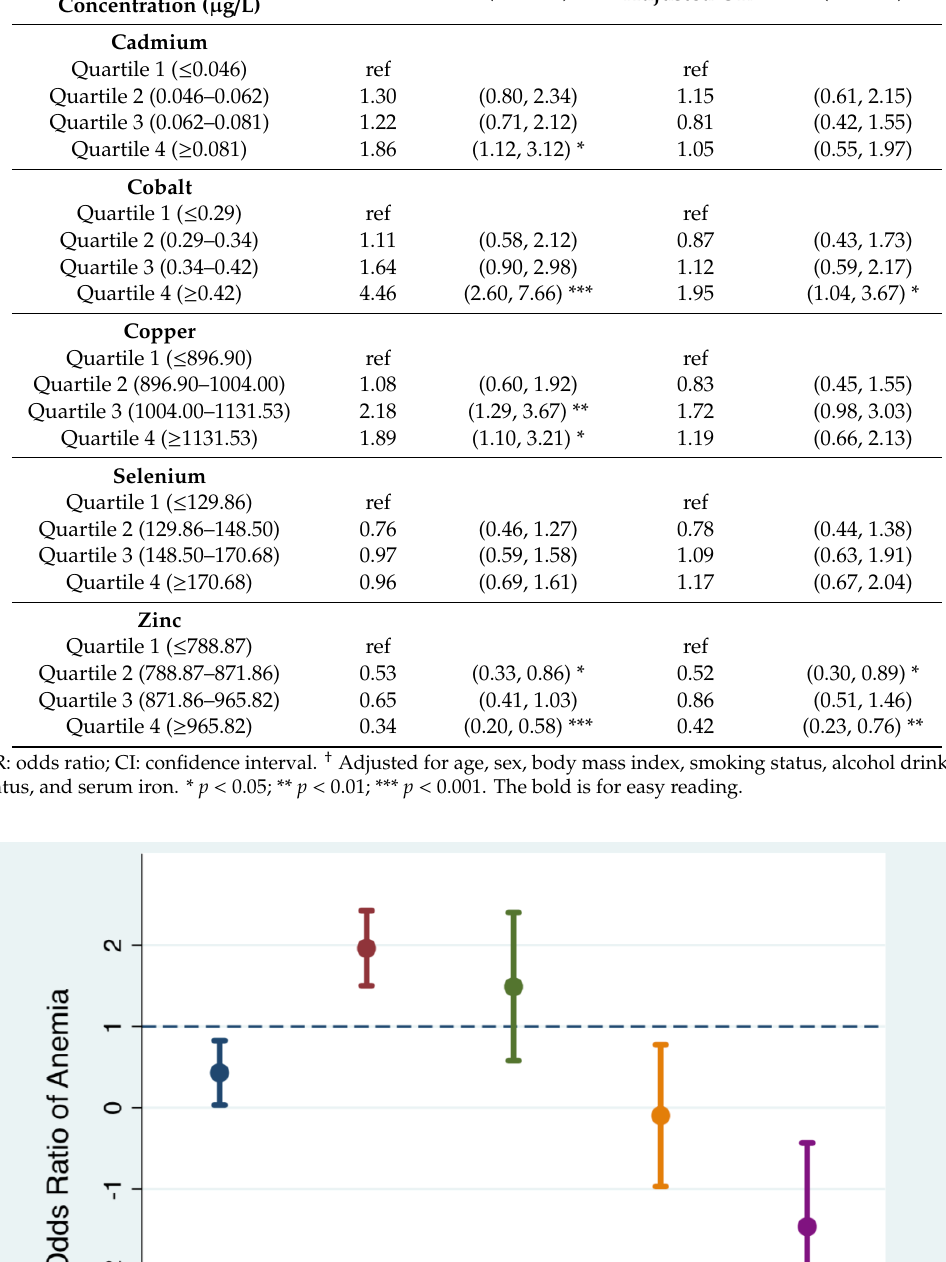
Table 5. Associations between serum trace elements concentration and risks of anemia (n = 1141). Serum Trace Elements